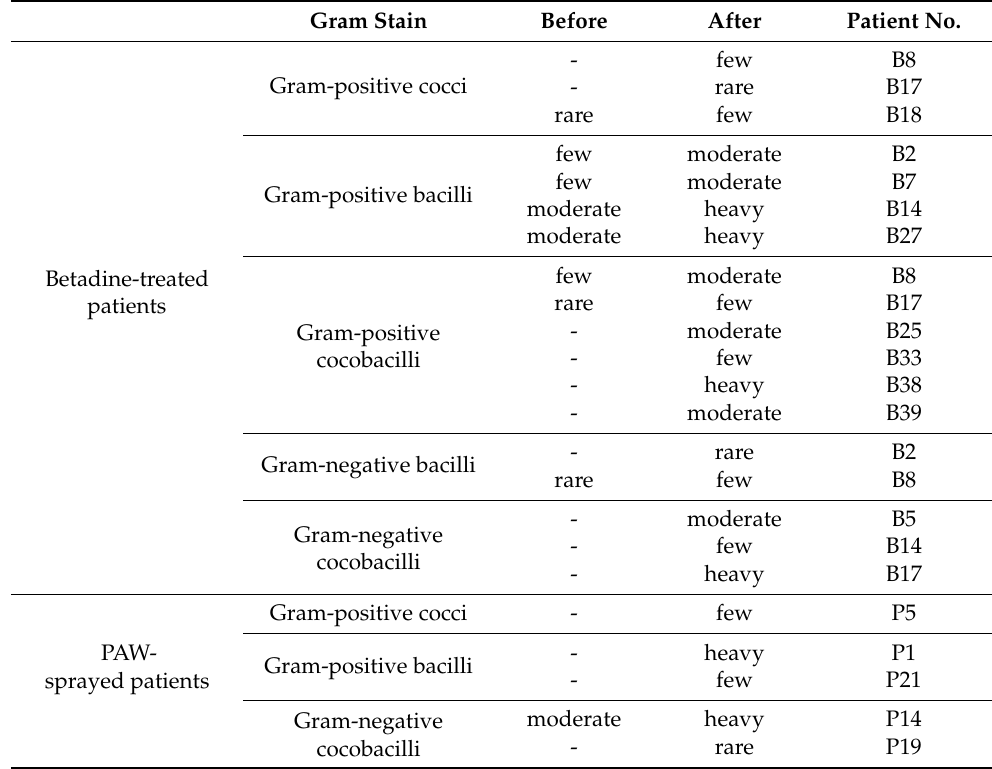
Table 2. A summary of the results of bacterial overgrowth case in the patients after treatment of betadine and